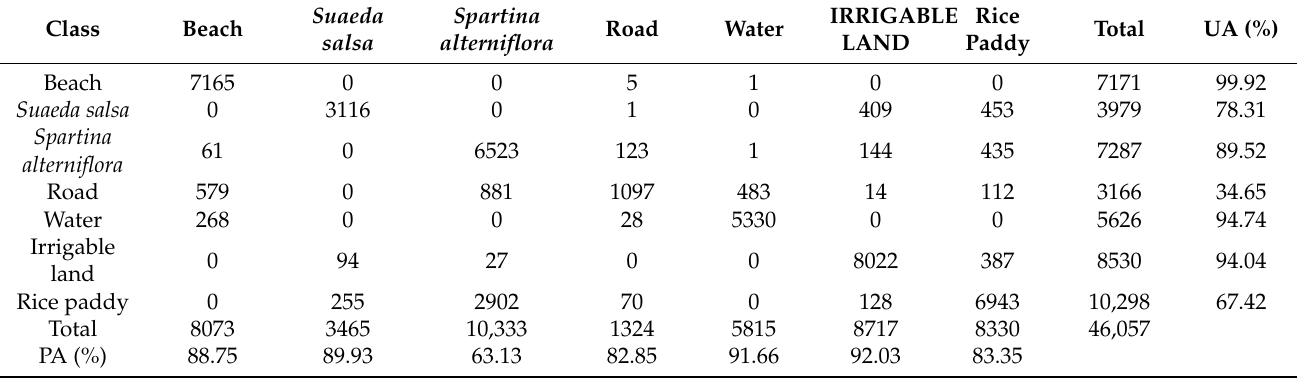
Table 6. Confusion matrix of the classification results from the Neu_tua/Neu_pha/Span features set using random